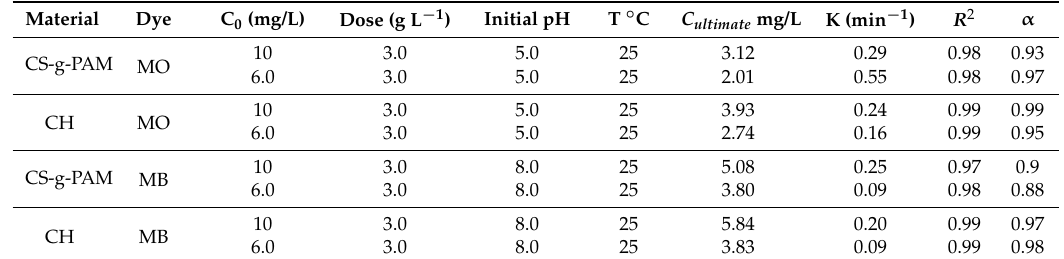
Table 1. Results of nonlinear regression of the experimental data of the decolorization of MB and MO by chitin and chitosan-g-PAM.